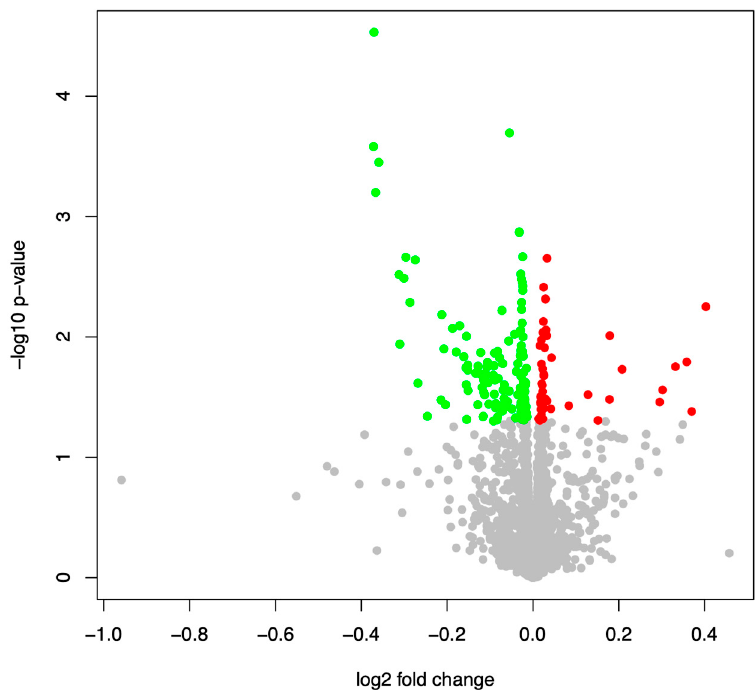
Figure 2. Volcano plot for the differentially expressed miRNAs in COPD patients surviving a 54-month period versus patients who died within this period. Significant miRNAs are indicated in red (overexpressed in surviving patients) or green (reduced expression in surviving patients).